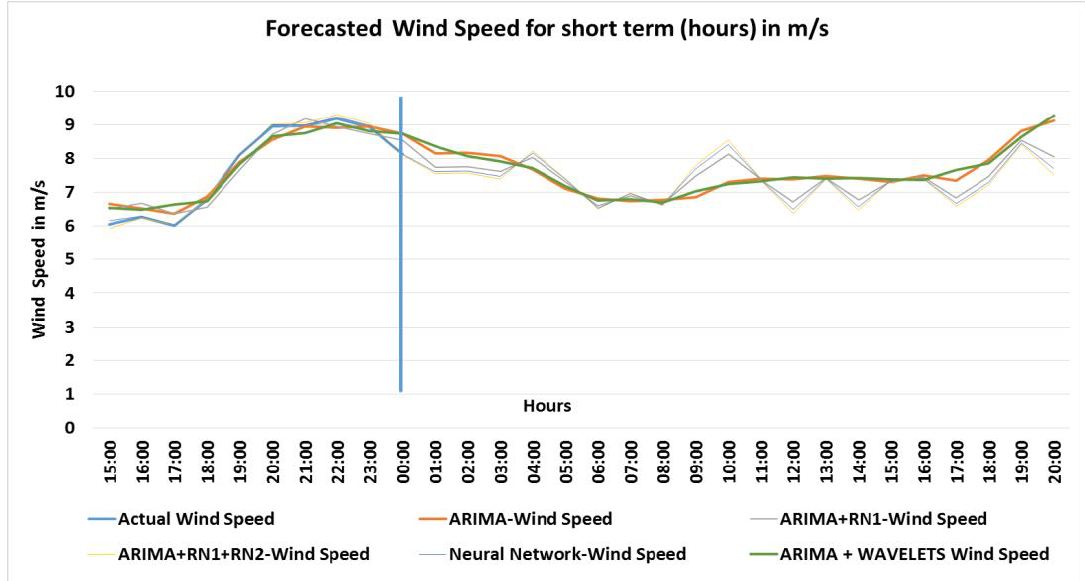
Figure 10. Short term (hours) forecasted Speed in m/s.